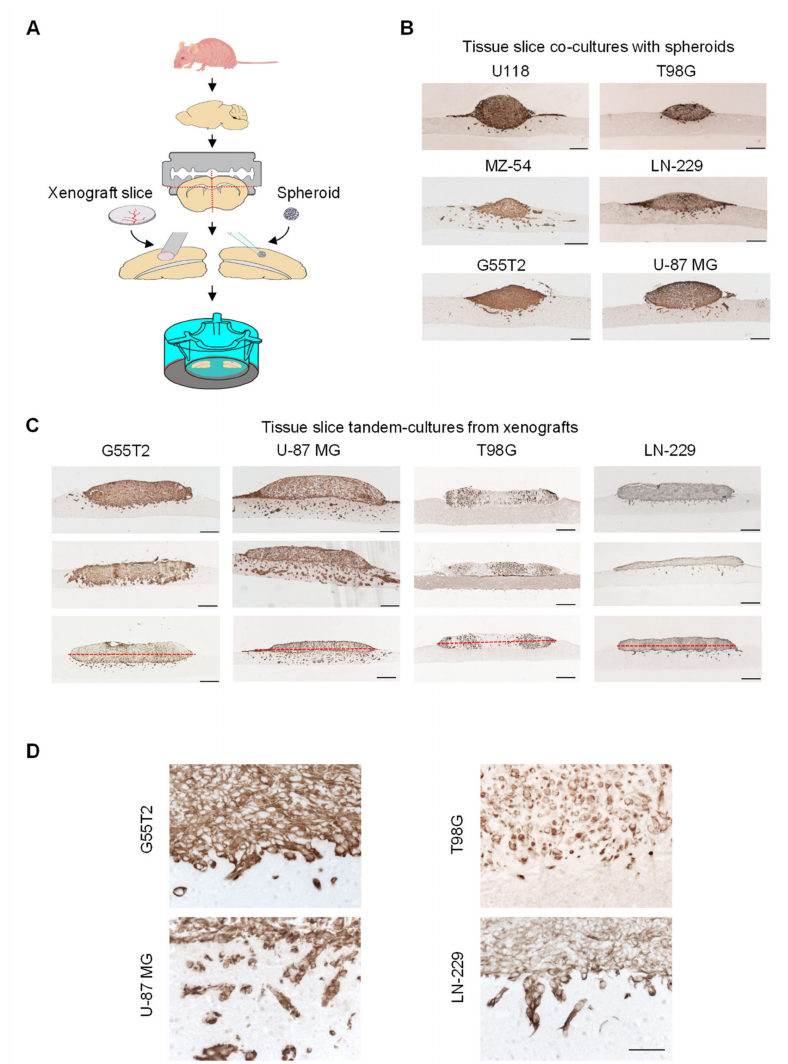
Figure 1. ( A ) Scheme of tissue slice tandem-culture preparation and cultivation, relying on the co-culture of a xenograft tissue slice on top of a normal brain tissue slice and thus replacing spheroid co-culture models based on established cell cultures. ( B ) Microscopic pictures of spheroid co-cultures and ( C ) xenograft tissue slice tandem-cultures (in triplicates) stained for Vimentin, based on di ff erent cell lines. Images were taken from tissue stained after one week of cultivation. ( D ) Higher magnification of representative segments from Figure 1C. Scale bars: 200 µ m ( B , C ), 50 µ m ( D